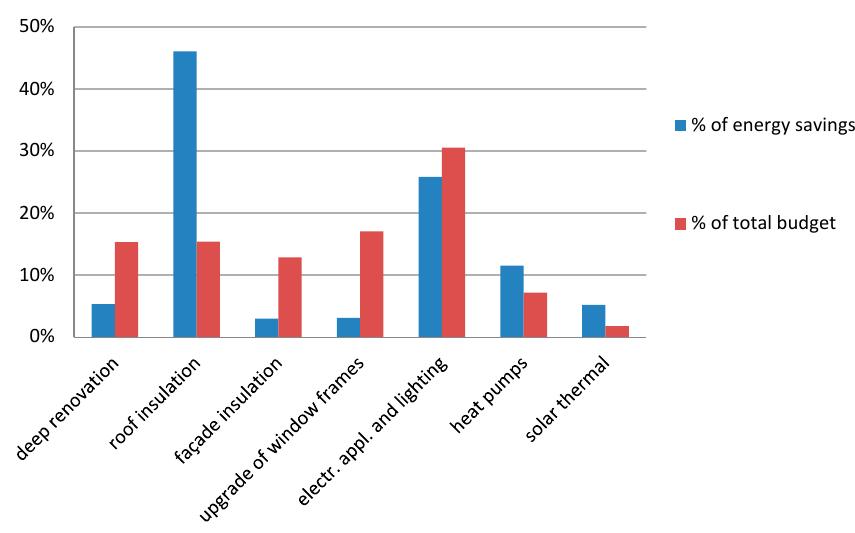
Figure 2. Contribution of energy renovations in single ‐ family houses to total costs and total energy savings.